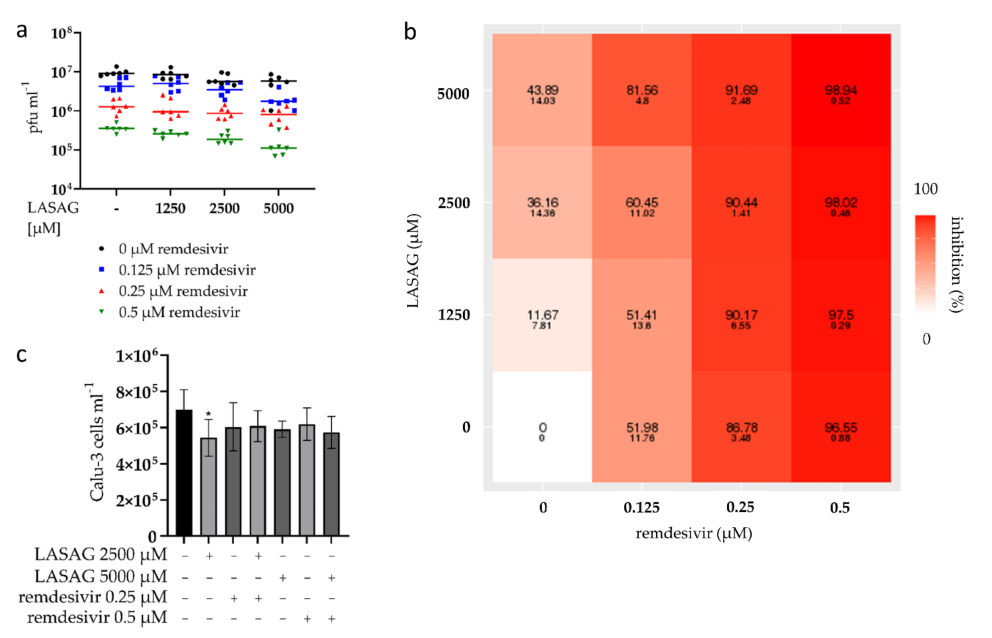
Figure 5. LASAG shows additive effects on SARS-CoV-2 replication in vitro when combined with remdesivir. Calu-3 cells were left untreated or were incubated with the LASAG–remdesivir